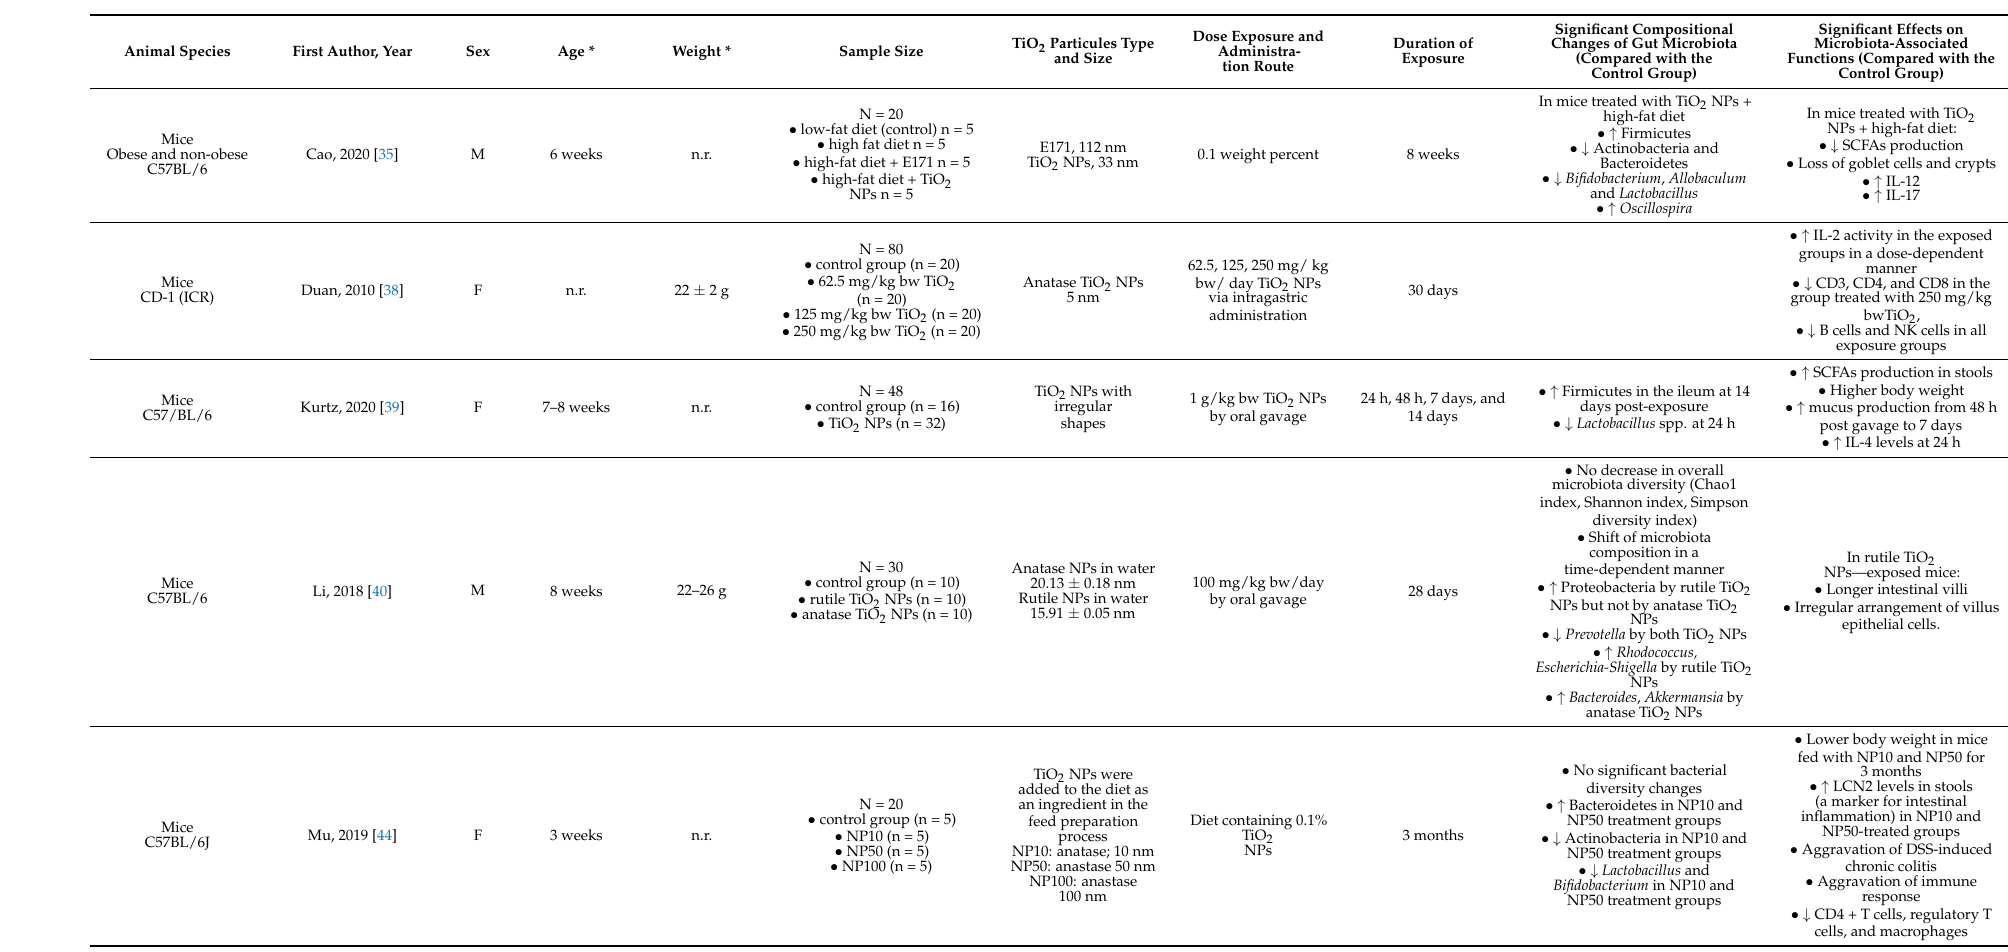
Table 2. Characteristics of included animal studies (listed by animal